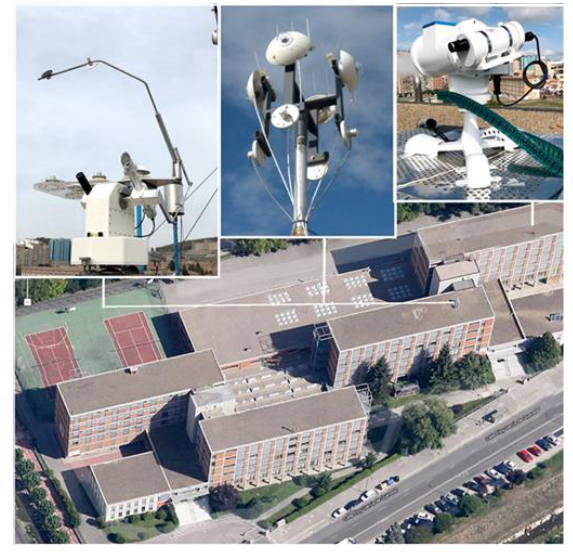
Figure 1. Location of the experimental equipment on the roof of the Higher Polytechnic School building at University of Burgos, Spain.